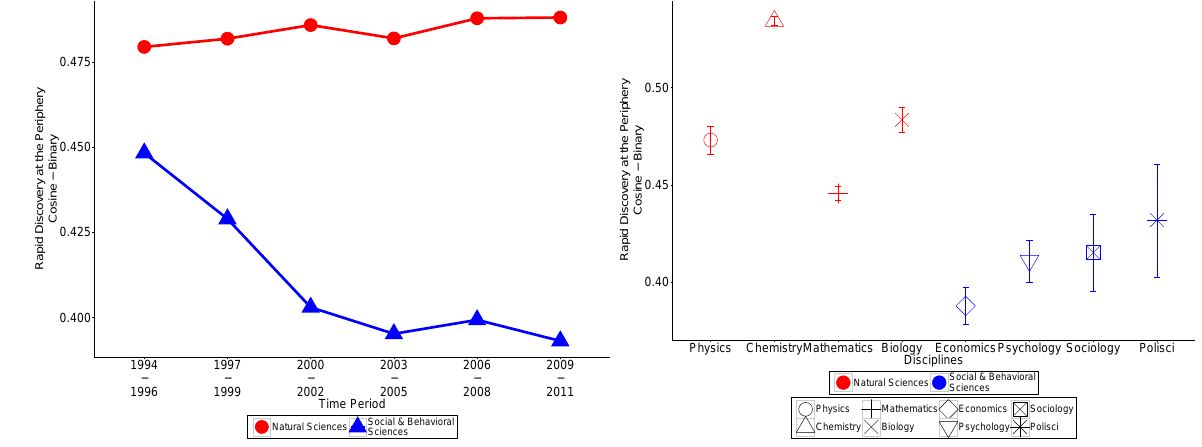
Figure 4: Rapid discovery values over time by science/social science group and discipline. disciplines. The discourse of scientific disciplines is more dissimilar over time